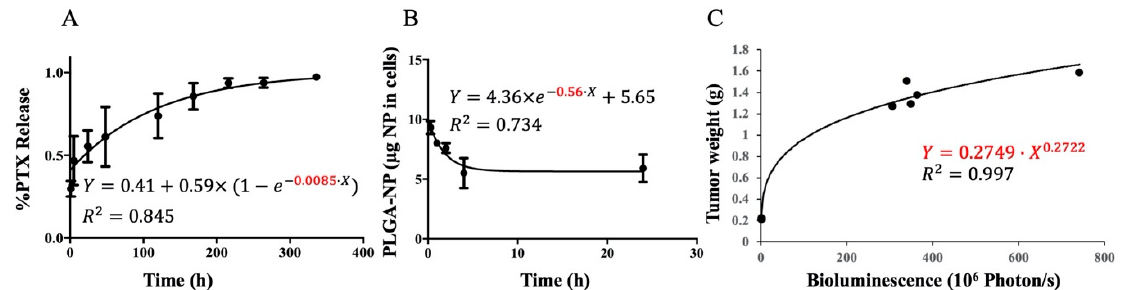
Figure 4. Estimations of the PTX release rate constant ( A ), PLGA NPs exocytotic rate constant ( B ) and the correlation between tumor weight and bioluminescence ( C ) with data collected from in vitro or in vivo studies. The derived PTX release rate constant ( K rel ) and PLGA NPs rate constant ( K exo ) are shown in red. The correlation estimated for tumor weight versus tumor bioluminescence is shown in red as well.